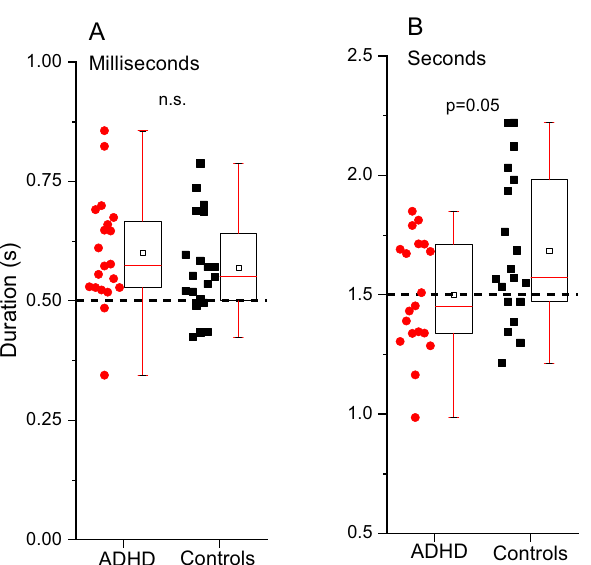
Figure 5. Box plots reporting point of subjective equality (PSEs) for the auditory time task in the millisecond ( A ) and seconds ( B ) ranges for the two groups of participants. Dotted lines report the physical value of the reference stimuli (0.5 s and 1.5 s). Symbols within the boxes reports median (line) and mean (open square) values.